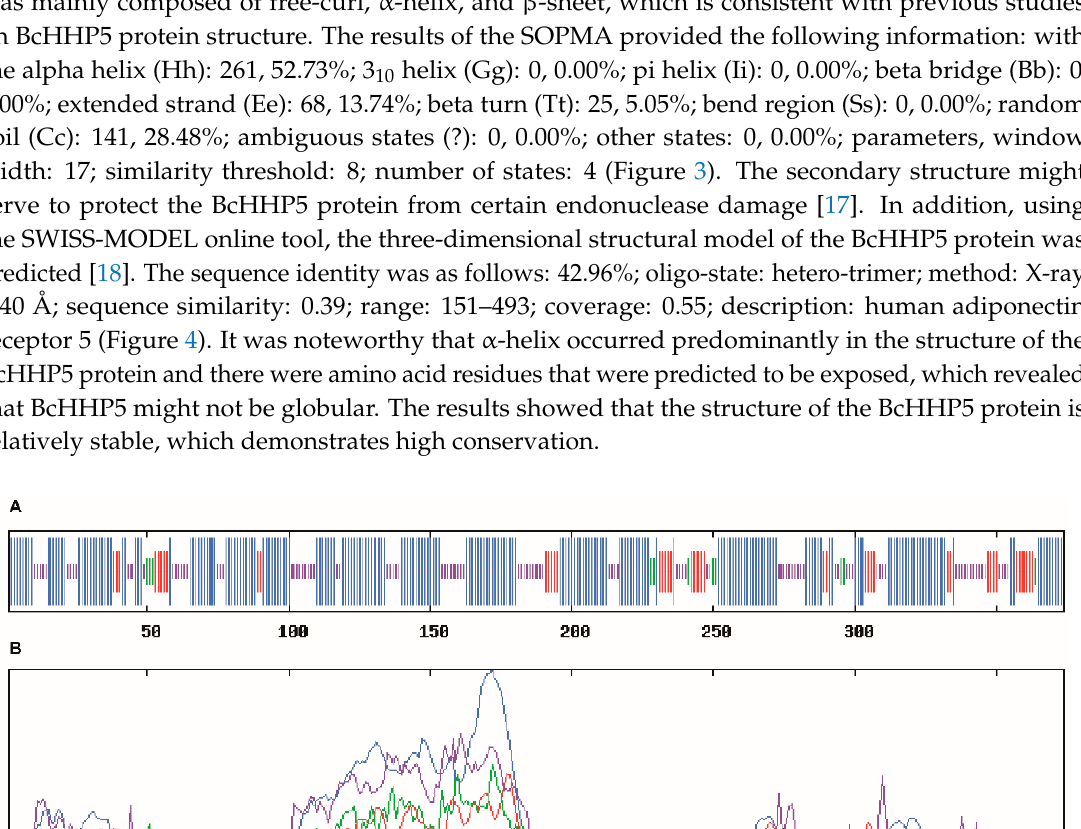
Figure 2. Conserved motifs in HHP . ( A ) Phylogenetic tree, conserved motifs, and their distribution in each HHP gene and the corresponding combined P-values; ( B ) the amino acid sequence of each motif. The font size means the frequency of the corresponding amino acid.